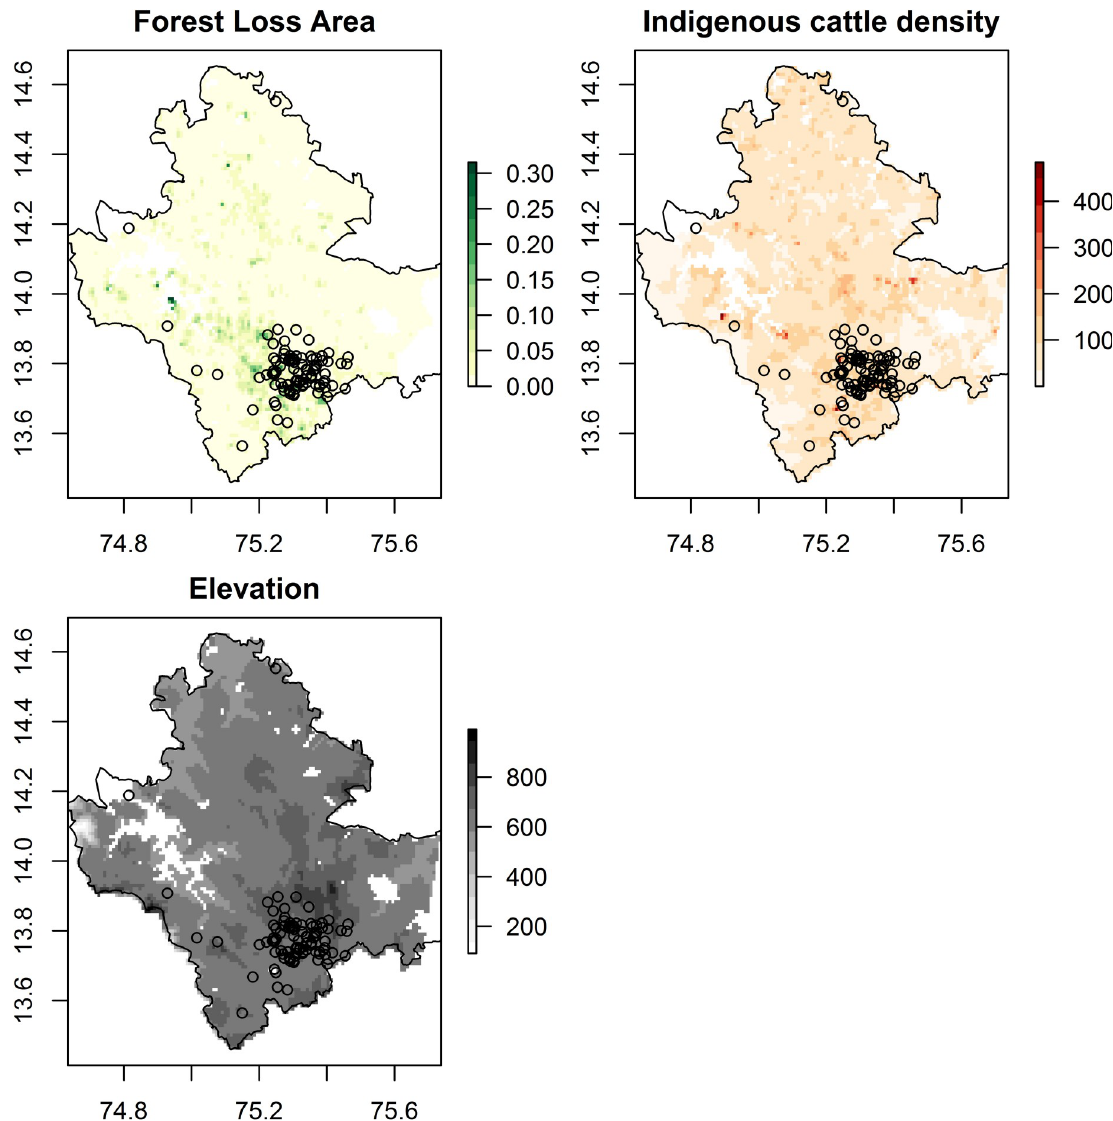
Fig 3. Other key predictors of presence of Kyasanur Forest Disease (1 km resolution) overlaid with point locations of human cases from 2014 to 2018 (black dots). These are area of forest loss, densities of indigenous cattle and elevation derived from Hansen et al. [44], from the Department of Animal Husbandry, Dairying and Fisheries, Government of India Census 2011 data, and from Shuttle Radar Topography Mission data version 4 respectively (see S3 File). Note that area of forest loss did not improve the overall accuracy of models. The administrative boundary dataset is from HindudstanTimesLabs (https://github.com/HindustanTimesLabs/shapefiles/), reproduced under the MIT License. Human case data are from Department of Health and Family Welfare Services, Government of Karnataka. White areas in Bhadravathi taluka in southeast corner indicate no